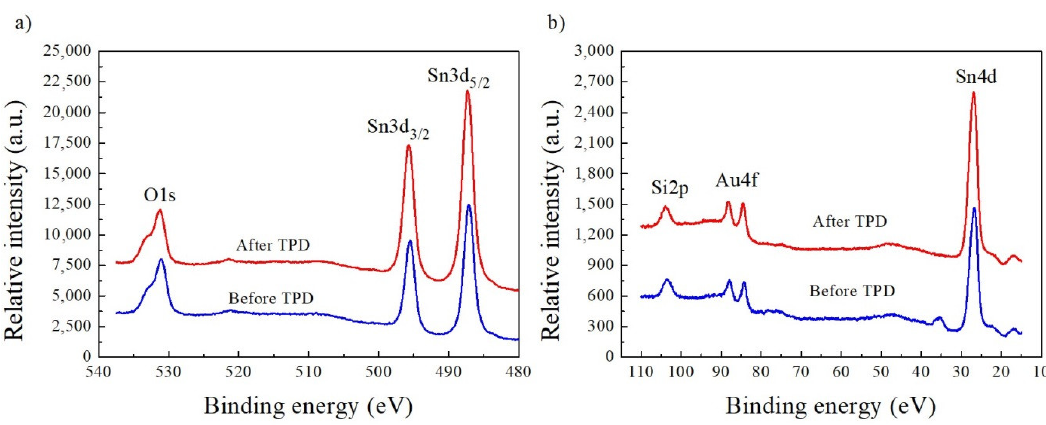
Figure 3. XPS spectral window of: ( a ) O1s and Sn3d, ( b ) Si2p, Au4f, and Sn4d of the VPD SnO 2 nanowires deposited on Au-covered Si (100) substrate before and after the subsequent thermal desorption spectroscopy (TDS) experiment.